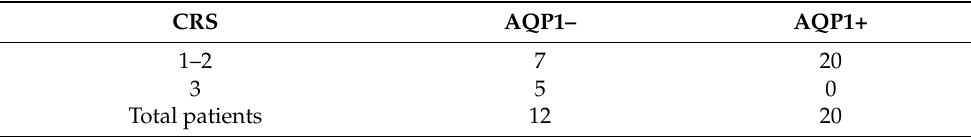
Table 2. Distribution of CRS scores according to AQP1